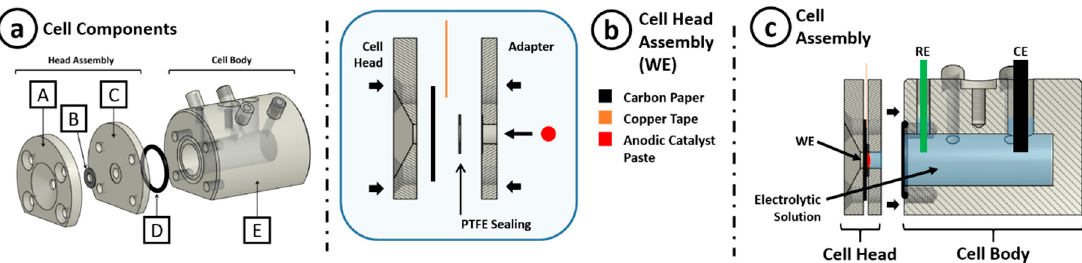
Figure 3. Experimental cell for Fixed Energy X-ray Absorption Voltammetry (FEXRAV) measurements at the K-alpha edge of Pd: ( a ) 3D ensemble view, depicting EC-cell components: A. Cell Head, B. PTFE sealing, C. Adapter, D. Sealing, E. Cell Body; ( b ) exploded section view of the cell head, ( c ) lateral section view of the assembled cell.